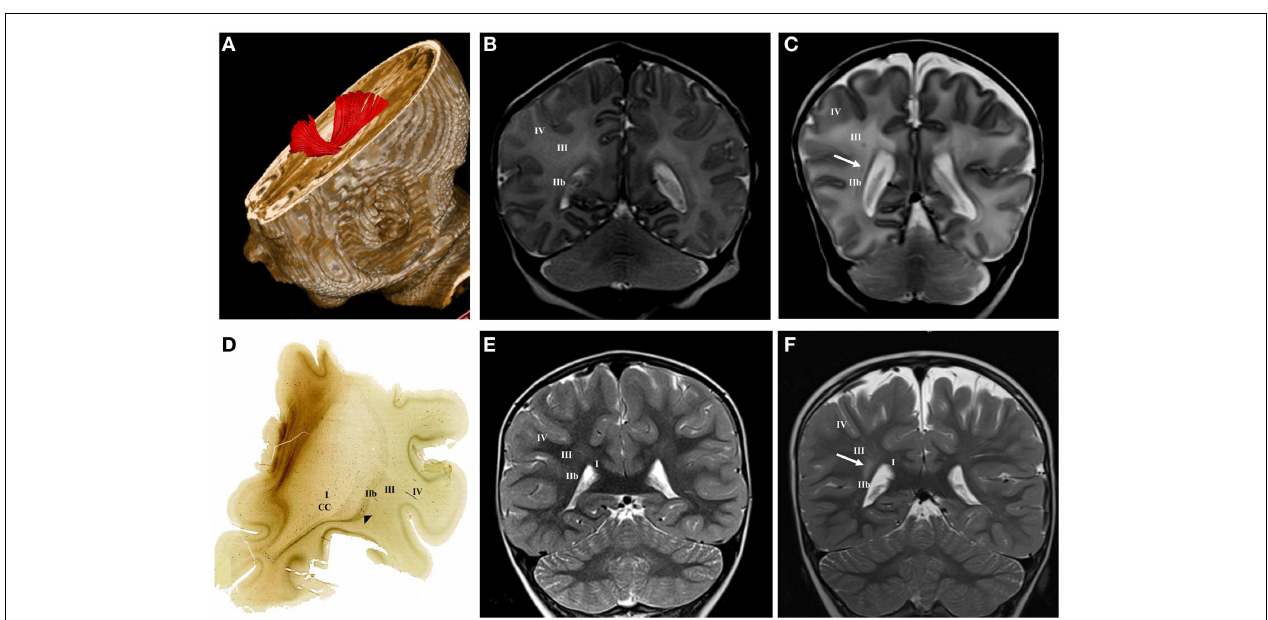
SNAPII = 16, SNAPPEII = 34, AS = 2/5) with punctate hemorrhagic lesion within sagittal strata at term equivalent age [arrow in (C) ] and hyper-intensive lesion of sagittal strata at the age of 3years [arrow in (F) ] onT2 coronal images. Numbers I–IV represent segments of white matter as previously described, CC, corpus